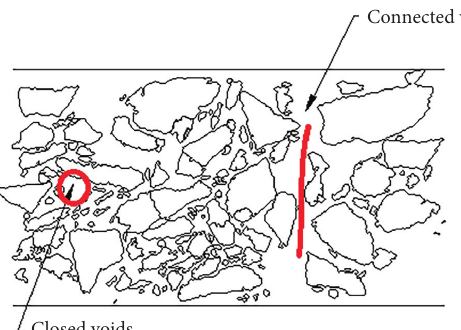
Figure 2: Porous asphalt mixture voids